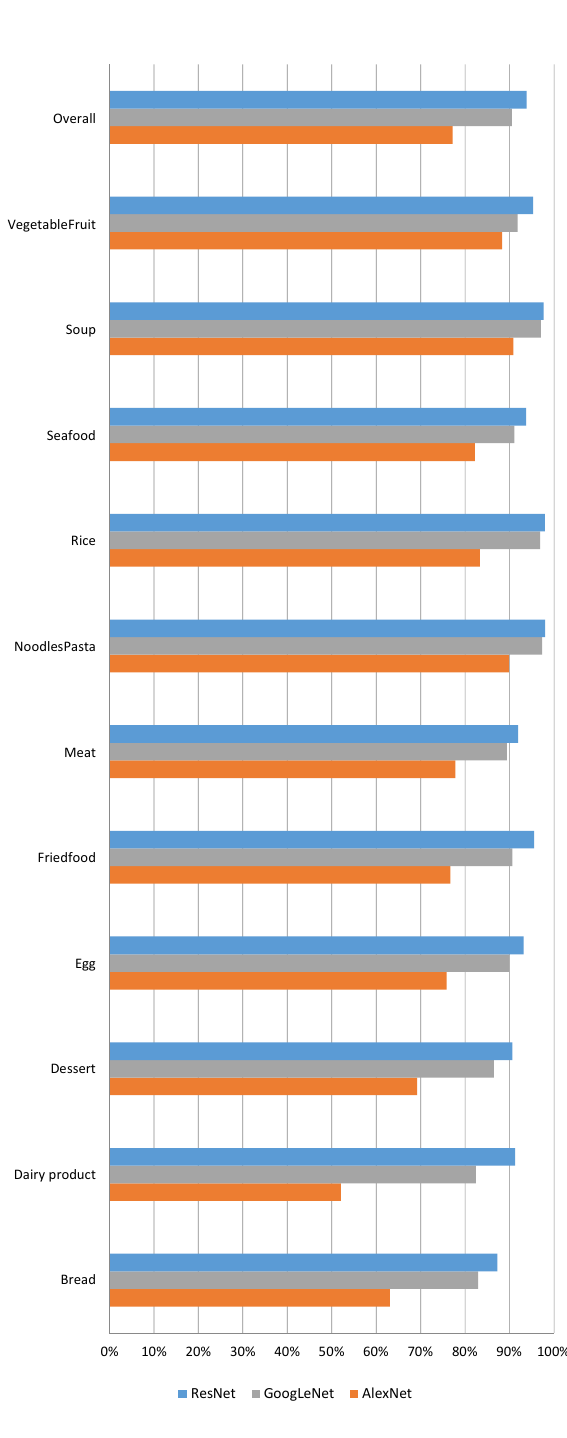
Figure 9. Accuracy with other existing deep CNN models.